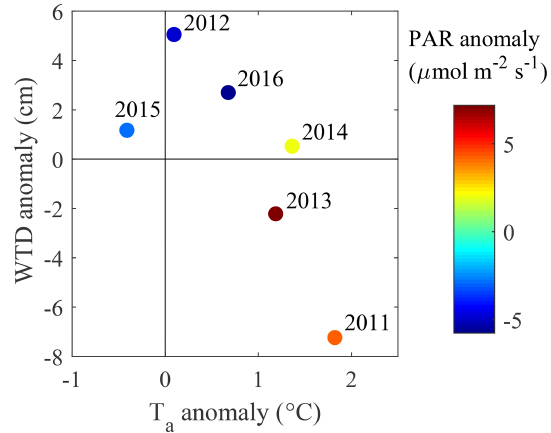
Figure 3. June–August deviations in water table depth, air tempera- ture and PAR, calculated as difference from the 6-year averages for WTD and PAR and 30-year averages for T a